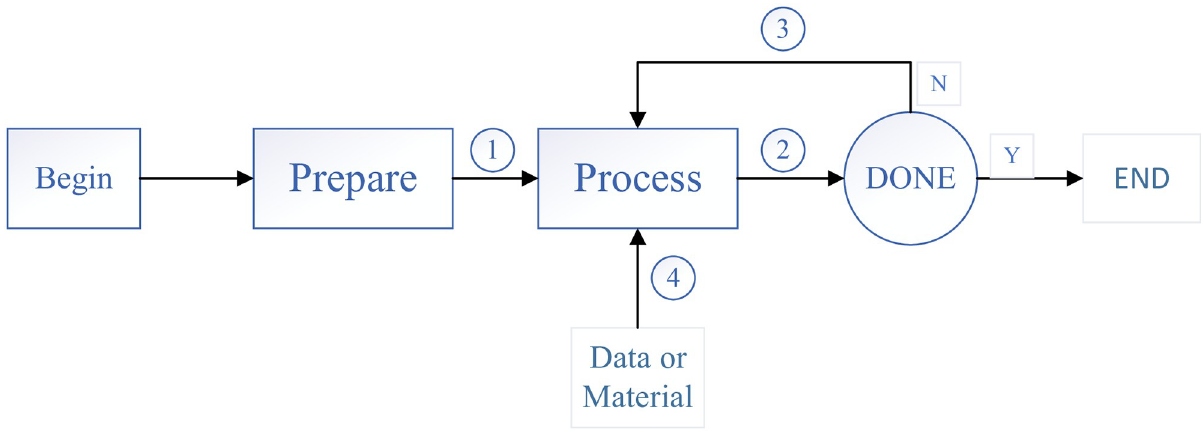
Fig 1. The steps of